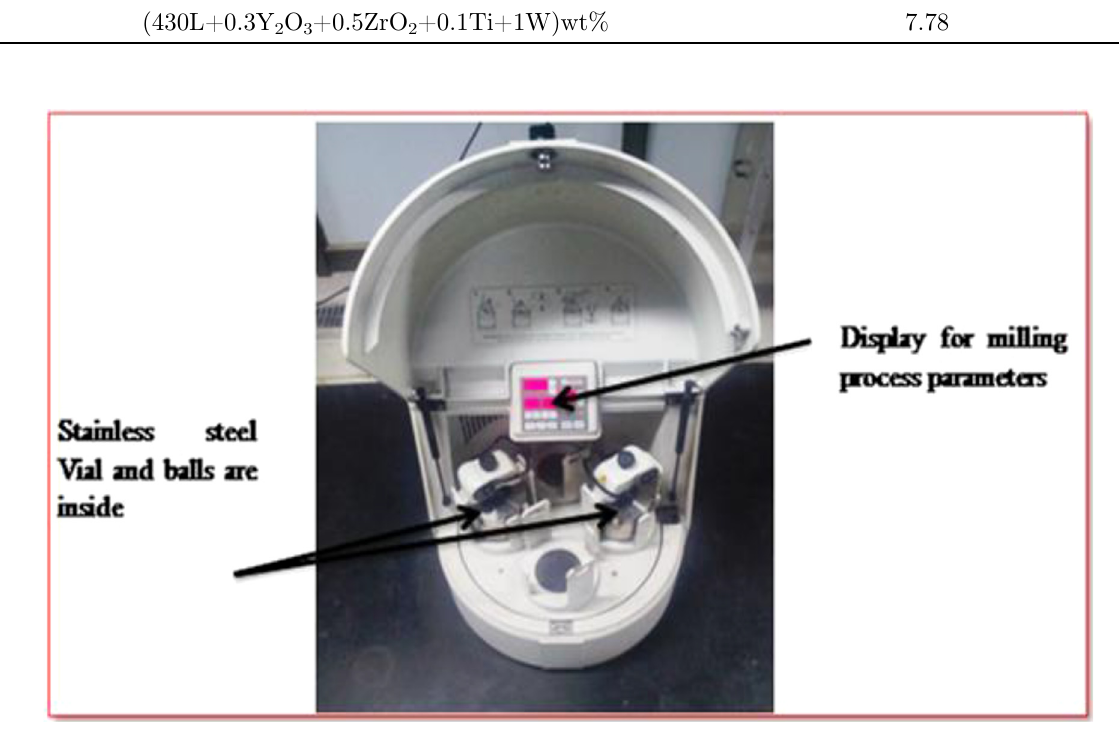
Fig. 1. High energy planetary ball milling